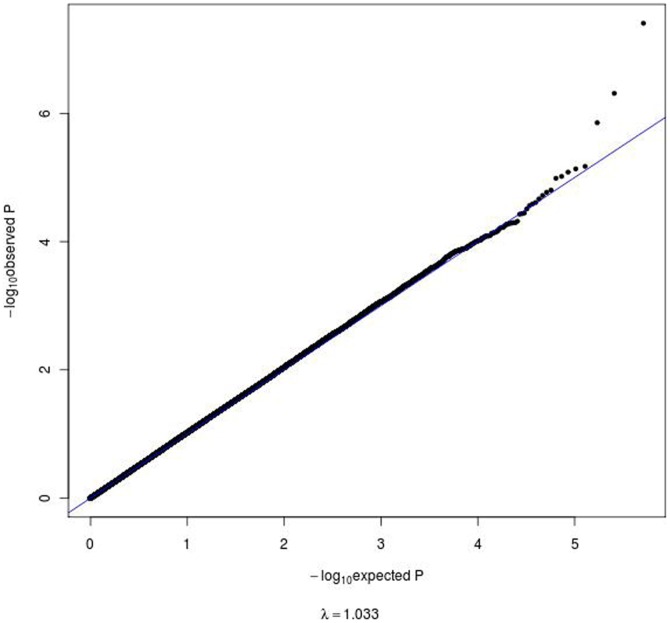
Quantile-Quantile plot of the GWAS results.In this plot, each dot corresponds to a SNP tested for association where the observed –log10 p values, shown by vertical axis, were plotted by the expected –log10 p values under the null hypothesis. Upper right dots with higher observed significance than expected represent candidate variants for association with the phenotype tested (CAD category 1, control subjects; CAD category 2, patients with ≤50% stenosis in any coronary artery; CAD category 3, patients with >50% stenosis in any of the coronary arteries). The genomic control ratio (λ) was 1.033, indicating the lack of strong effect of systematic error such as population stratification.